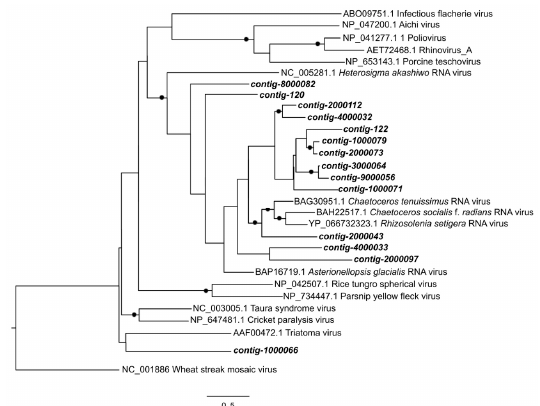
Figure 7. Maximum Likelihood tree showing the viral RNA-dependent RNA-polymerase (RdRp) contigs which contributed most to the dissimilarity between freshwater and brackish/saltwater samples in Similarity Percentage (SIMPER) analysis (>1% contribution). Closed circles show nodes with bootstrap values >50 (out of 100). Scale bar shows number of substitutions.